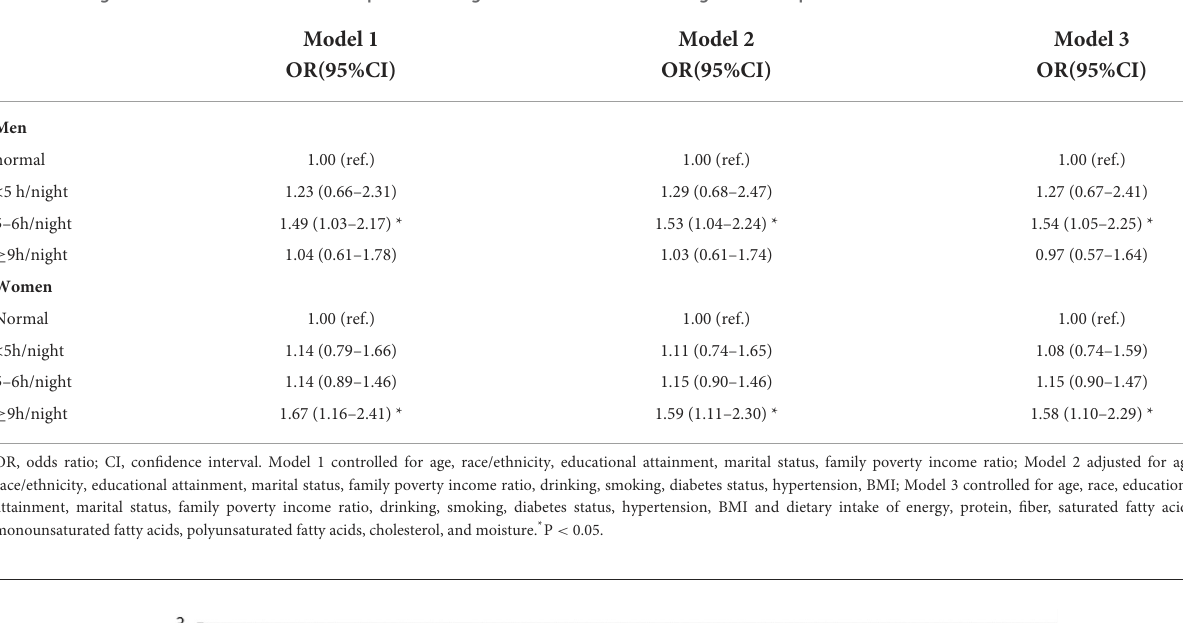
TABLE 2 weighted ORs and 95%CIs for constipation among men and women according to the sleep duration.